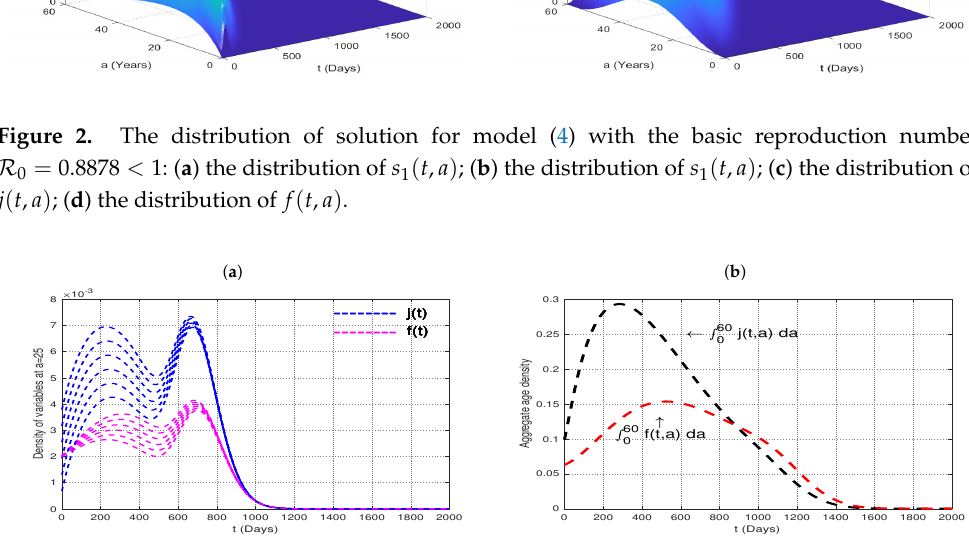
Figure 3. The global asymptotical stability of disease-free steady state of model (4) with the basic reproduction number R 0 = 0.8878 < 1, which implies that the disease dies out: ( a ) the trajectories of i ( t ,25 ) and f ( t ,25 ) starting from differential values; ( b ) the cumulative distributions of i ( t , a ) and (cid:82) 60 (cid:82) 60 j ( t , a ) , that is, i ( t , a ) d a and f ( t , a ) d a 0 0